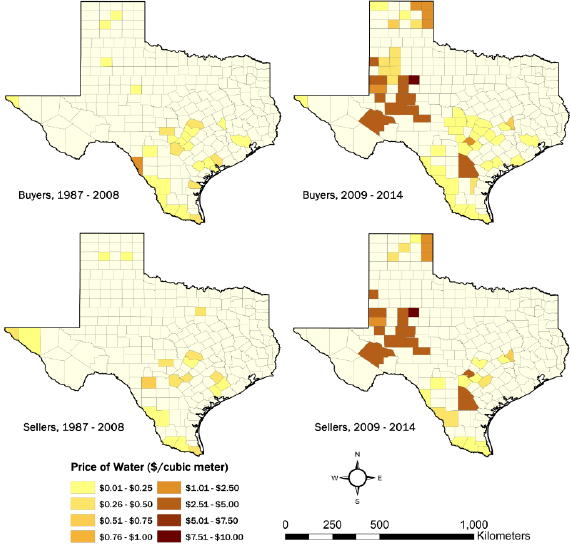
Figure 6. Water transactions across the state of Texas often occur in local markets in the Lower Rio Grande Valley below Falcon Dam, in the Edwards Aquifer area, and in Northwest Texas. Between 2009 and 2013, transactions increased in South and West Texas and in the Panhandle due to the increase water demand for hydraulic fracturing. Data were compiled from various sources including private operators and [12,22,24,49–67].